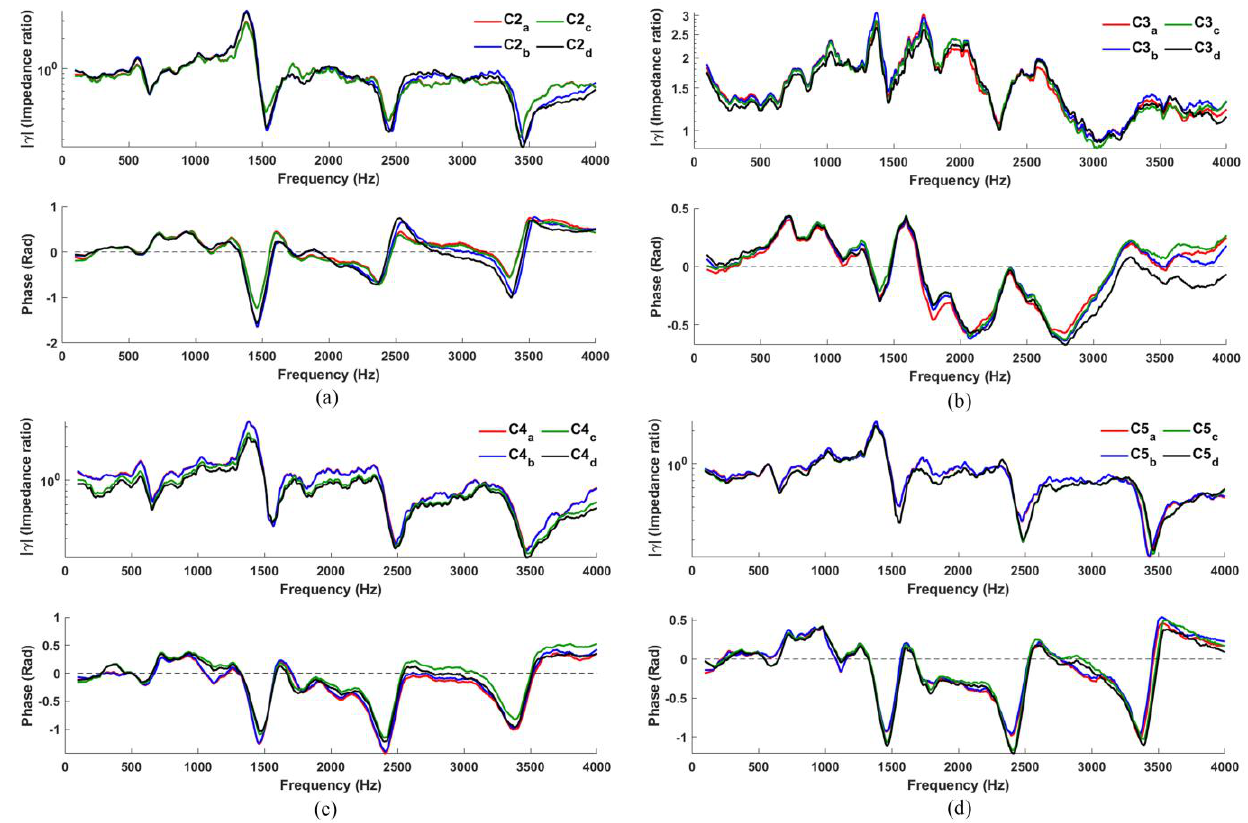
Figure 5. Typical γ(f) measured using configuration: ( a ) C2; ( b ) C3; ( c ) C4; ( d )